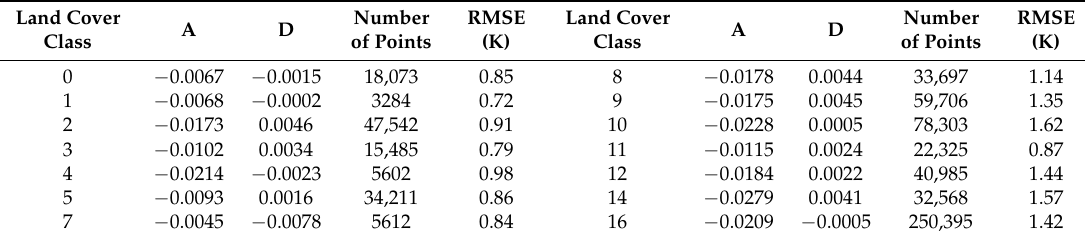
Table 3. Specification of the Vinnikov model for different land cover